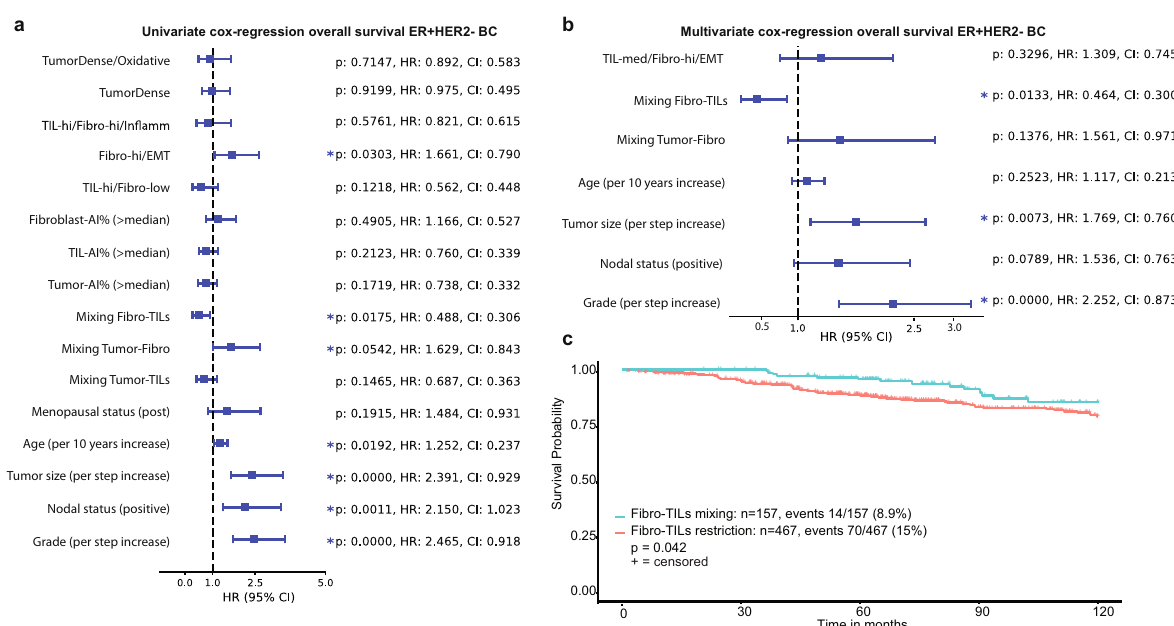
Fig. 5 Spatial characteristics of ER + HER2 − breast cancer show prognostic value. a Univariate cox regression. Hazard ratios (HR) with 95% con fi dence intervals (CI) for the spatial measurements and clinical parameters for ER + HER2 + samples only ( N = 603). P -values non-adjusted for multiple testing. b The multivariate cox regression for the signi fi cant univariate variables under a Hazard ratios (HR) with 95% con fi dence intervals (CI) on x -axis. c The overall survival probability of ER + HER2 − tumors with a low D KL ð P Fibroblast jj P TILs Þ ( = mixed) and high D KL ð P Fibroblast jj P TILs Þ ( = restricted). P values under a and b are the result of the log likelihood ratio